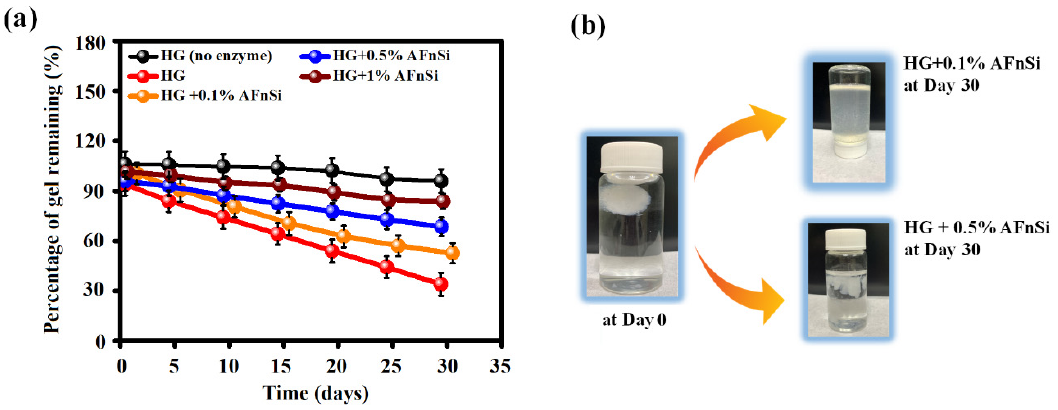
Figure 9. In vitro degradation rate ( a ) of the HG hybrid hydrogel with different concentrations of the AFnSi crosslinker (0, 0.1, 0.5, and 1.0% ( w / v )), respectively, for 30 days by 2.5 U/mL hyaluronidase enzyme. Optical image of hydrogel immersed in PBS with 2.5 U/mL hyaluronidase at day 1 (HG+0.1% AFnSi, HG+0.5% AFnSi immersed in PBS with 2.5U/mL hyaluronidase at day 30 ( b ).